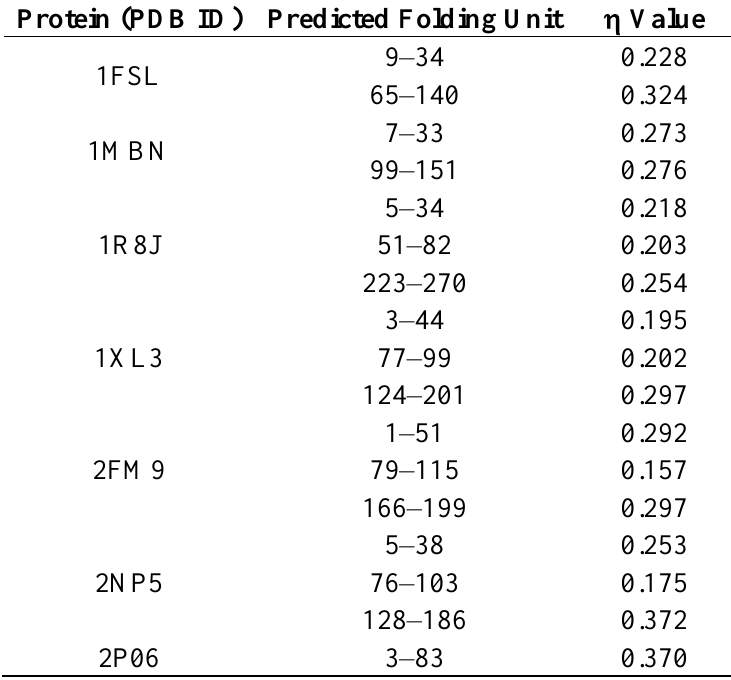
Table 2. The summary of the results of the